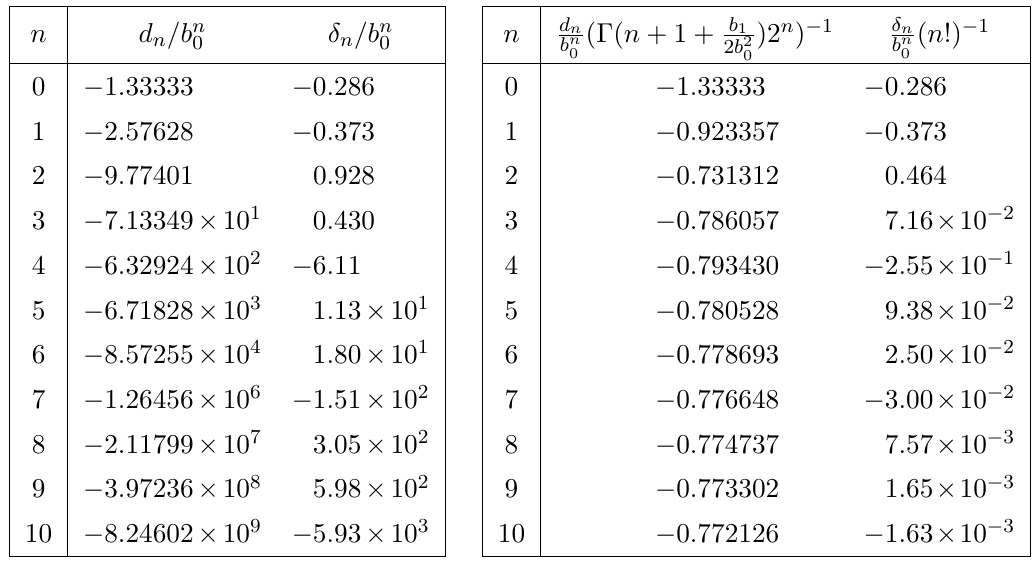
Table 2 . Original perturbative coe(cid:14)cient d n and renormalon subtracted perturbative coe(cid:14)cient (cid:14) n . In the right panel, we divide d n by the large order behavior expected from the u = 1 = 2 renormalon, and divide (cid:14) n by n !. We take n f =